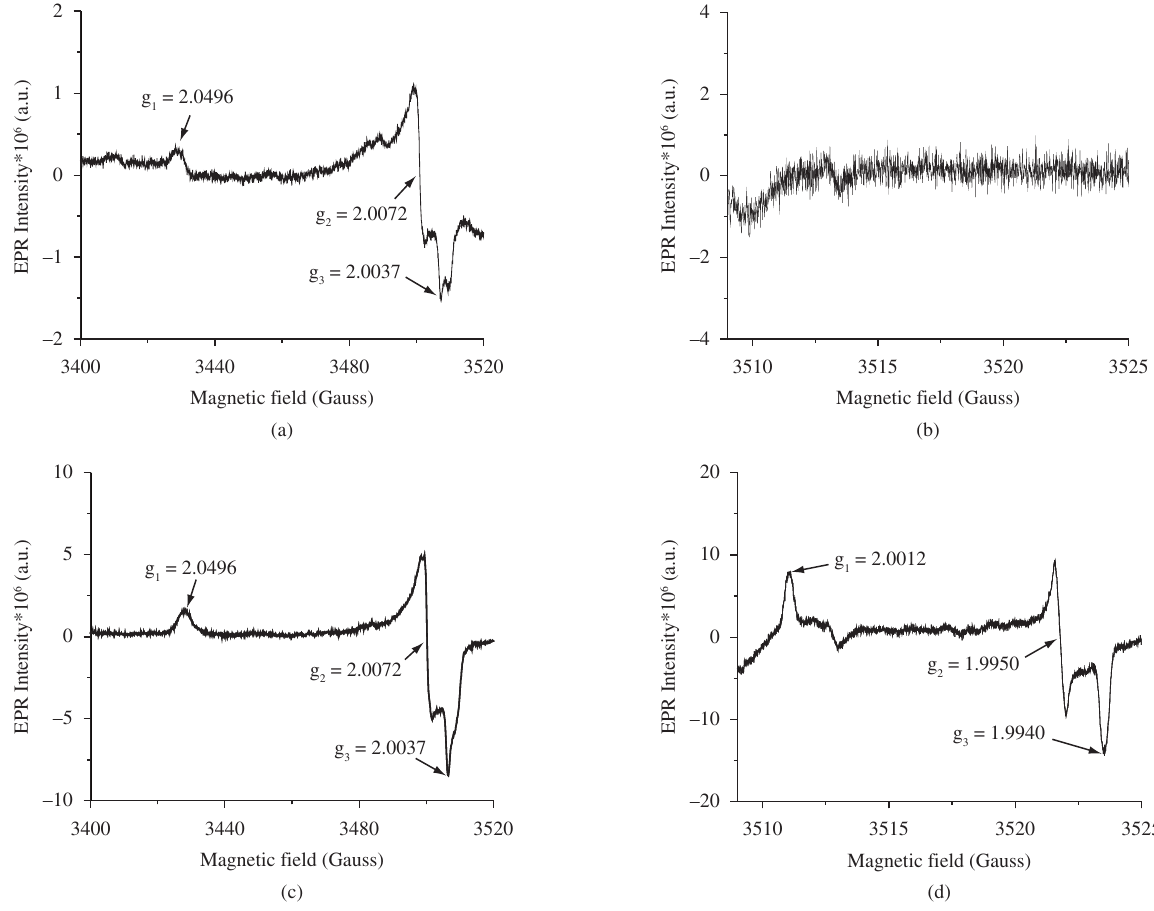
Figure 6. EPR spectra of quartz particles with D